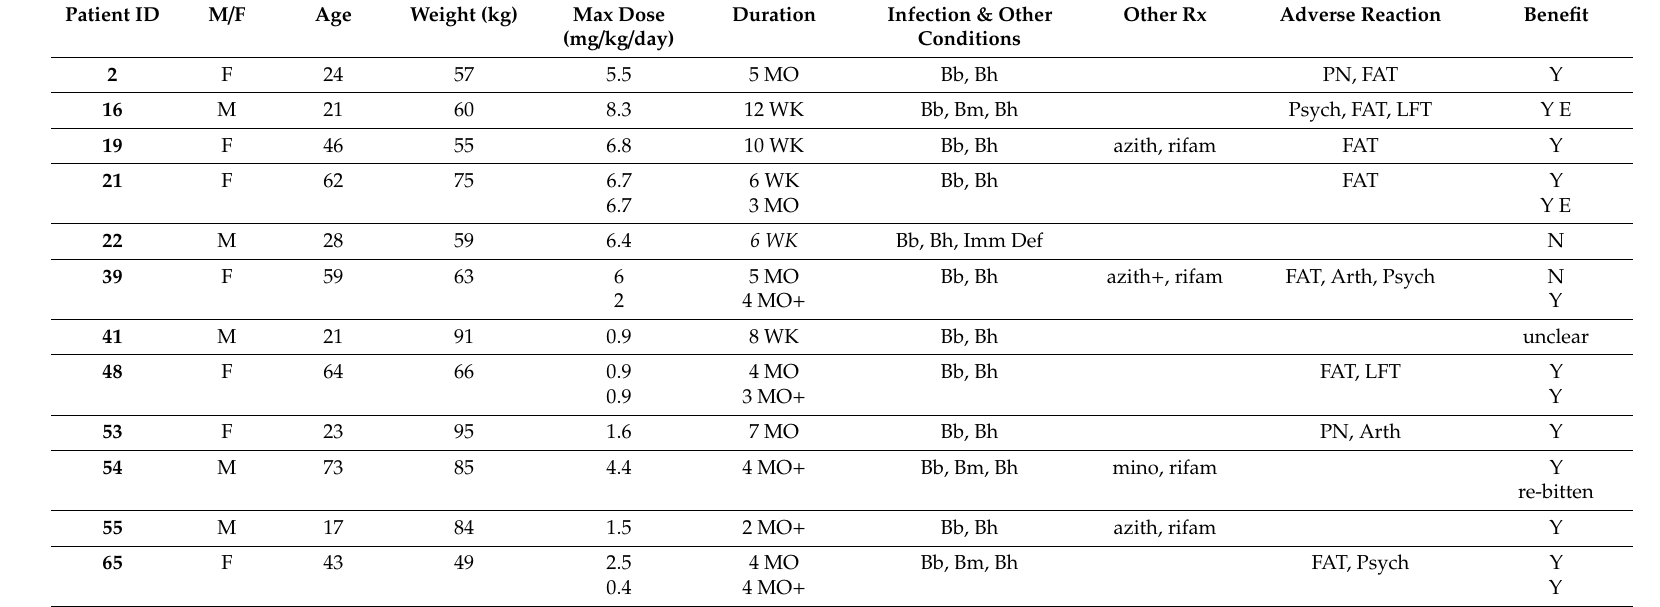
Table 5. E ff ects of disulfiram treatment on bartonella co-infection of Lyme disease ( n =